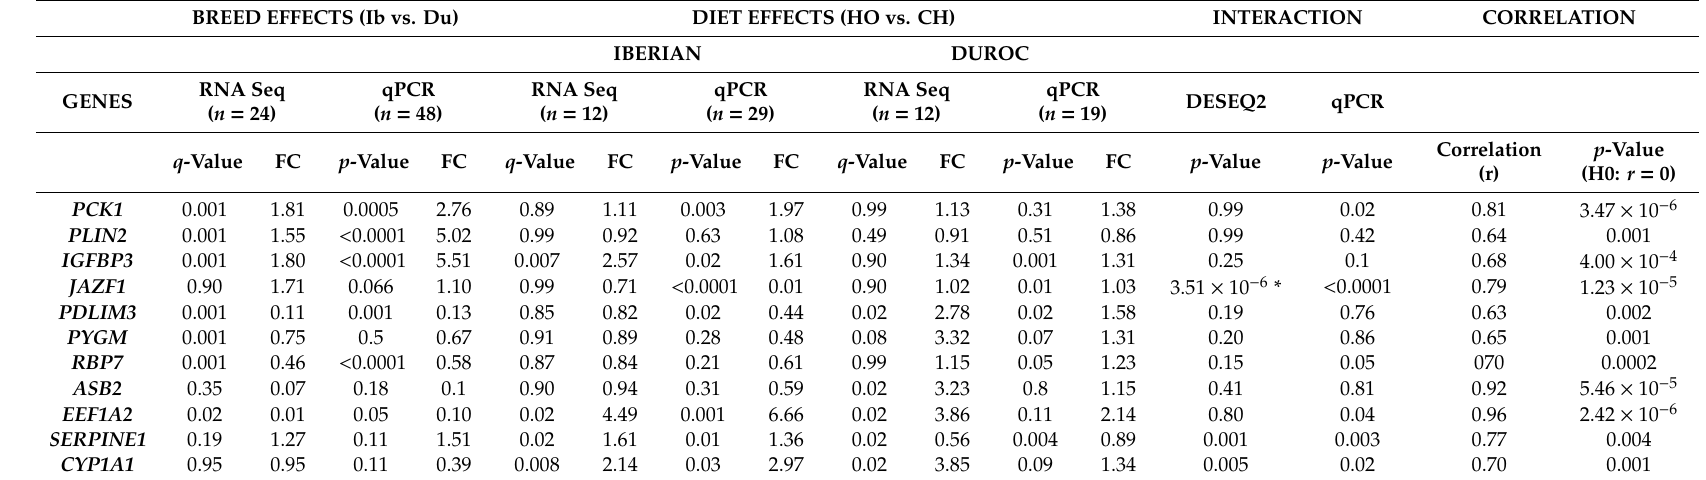
Table 1. Technical and biological validation of RNA-Seq results by quantitative PCR (qPCR): genes, statistical significance, and fold change values (FC) obtained with both techniques for the breed, diet, and interaction e ff ects, and Pearson correlations between expression values obtained from both techniques. BREED EFFECTS (Ib vs.